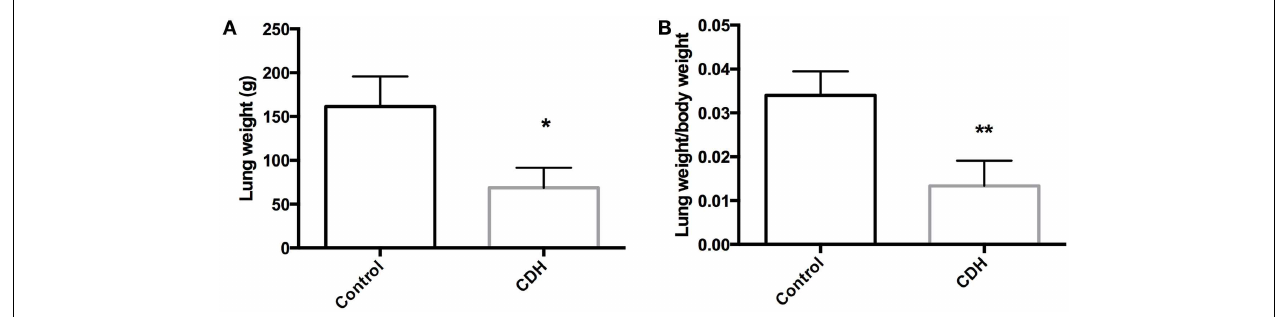
and two control twins underwent sham thoracotomy. Two CDH fetuses and one singleton control aborted. Of the remaining five CDH lambs, two CDHs closed with no persistent diaphragmatic defect at delivery, leaving three CDH lambs. One singleton con-